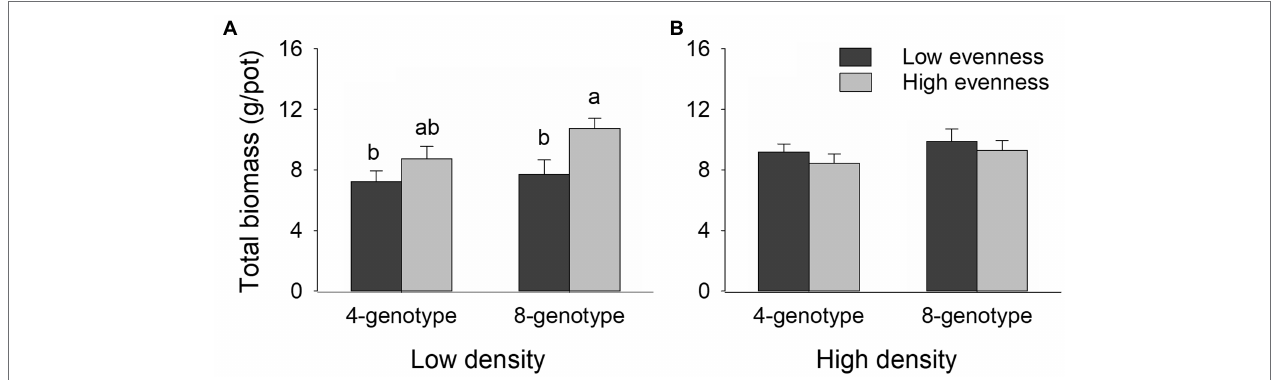
FIGURE 2 | Effects of genotypic richness (4-gneotype vs. 8-genotype), genotypic evenness (low vs. high evenness), and plant density (low vs. high density) on total biomass (A,B) of Hydrocotyle vulgaris population. Mean values (+1 SE) are presented; see Table 1 for statistic results. Different letters (a–b) at the end of bars indicate significant difference in each